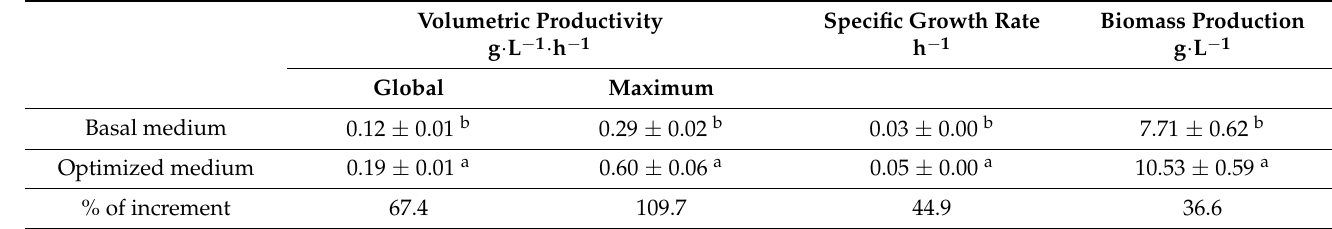
Table 4. Maximum and global volumetric productivities (g · L − 1 · h − 1 ), specific growth rates (h − 1 ), and biomass production (g · L − 1 ) of heterotrophic cultures grown using the company’s basal medium and optimized medium. Different letters indicate significant differences between media. Values are given as means ± standard deviation ( n = 3).